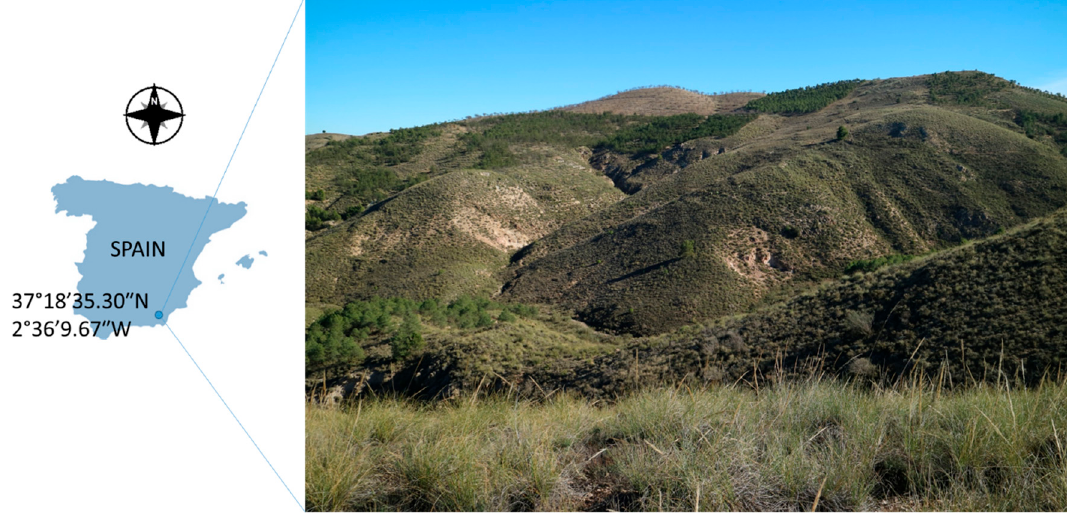
Figure 1. Location and landscape of the study area in Sierra de los Filabres, Almería province, southern Spain.